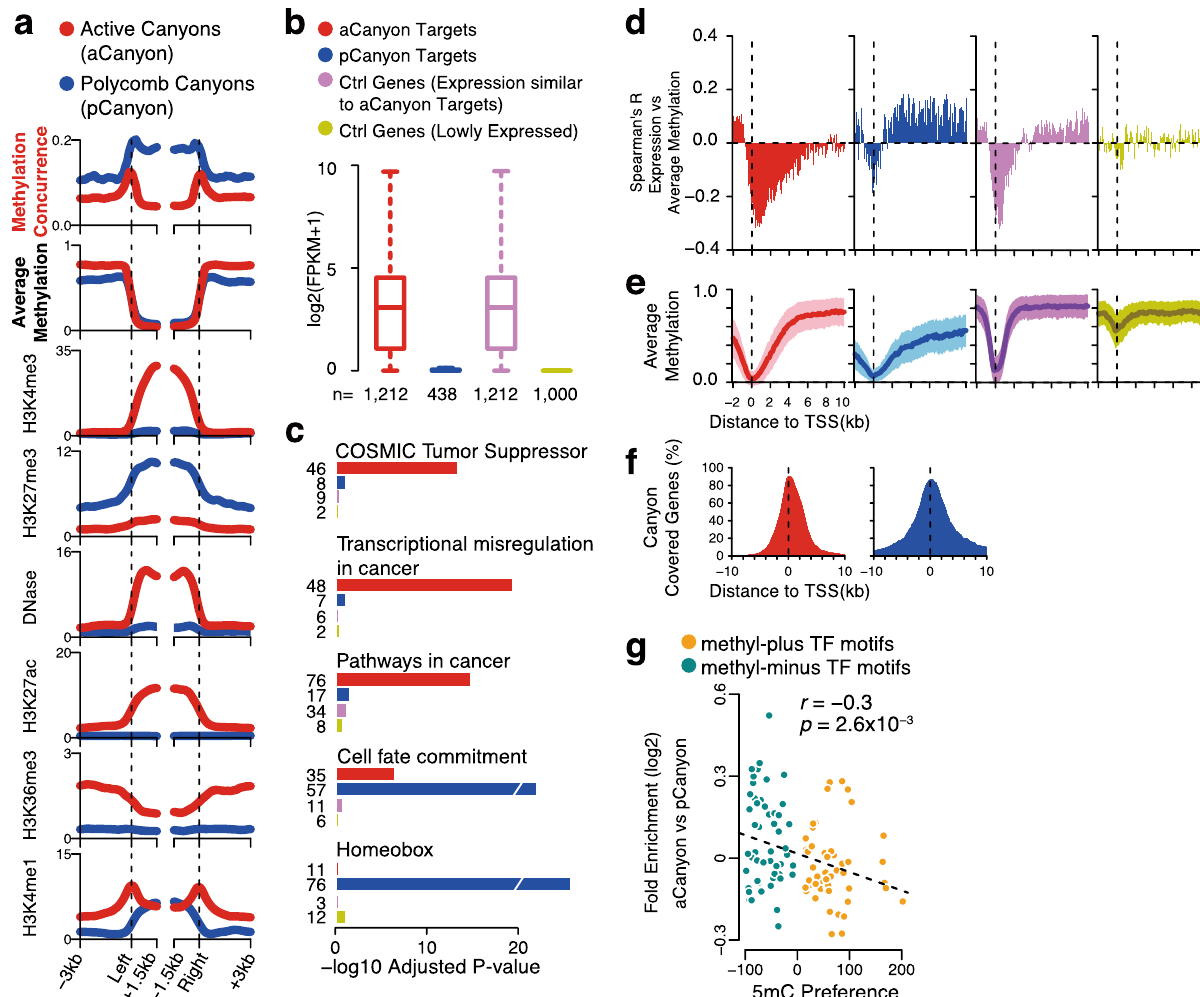
Fig. 4 Distinct characteristics of methylation canyons categorized by methylation concurrence. Average pro fi les of methylation concurrence, average methylation, DNase I hypersensitive sites, H3K4me3, and H3K27me3 in methylation canyons in CD3 + T cell. ‘ aCanyons ’ (red) are low-concurrence canyons. ‘ pCanyons ’ (blue) are high-concurrence canyons. The X -axis indicates the distance to canyon borders. b Expression of aCanyon target genes (red, n = 1212), pCanyon target genes (blue, n = 438), control group which features a similar expression distribution as aCanyon Targets (purple, n = 1212), and control group of randomly selected lowly expressed genes (gold, n = 1,000). The line in the box center refers to the median, the limits of box refer to the 25th and 75th percentiles and whiskers are plotted at the highest and lowest points within the 1.5 times interquartile range. Lists of aCanyons and pCanyons are in Supplementary Data 3, together with their target genes. c Functional enrichment analysis of aCanyon target genes, pCanyon target genes, and control groups. Enriched gene counts in each group are indicated on the left side. P-values were measured by two-tailed Fisher ’ s Exact Test and adjusted by the Benjamini – Hochberg method. d Spearman correlation between gene expression and average methylation of 100 bp-bin in gene regions. In total, 120 bins from − 2 kb to 10 kb were measured. e The pro fi les of average methylation for each gene group. The standard deviations are indicated by the width of the shaded area. f The Canyon distribution around the TSS. In each position from TSS − 10 kb to TSS + 10 kb, the percentage of aCanyon (red) and pCanyon (blue) target genes covered by Canyon is shown on the Y -axis. g Relationship between fold enrichment and 5mC preference of TF motifs. Each dot represents a motif. Y -axis indicates the fold change (log2) between enrichment at aCanyon and enrichment at pCanyon of the same motif (see Methods). The X -axis shows the 5mC preference of motifs measured by the SELEX technique. ‘ methyl-plus ’ TFs prefer to bind methylated sequences, while binding of ‘ methyl-minus ’ TFs are not favored by 5mC. The list of ‘ methyl-plus ’ and ‘ methyl-minus ’ TFs are in Supplementary Data 4. Spearman ’ s rank correlation was used. P values were calculated by the two-tailed correlation test for Spearman ’ s correlation. A linear model was plotted to describe the relationships between variables (indicated by the dashed